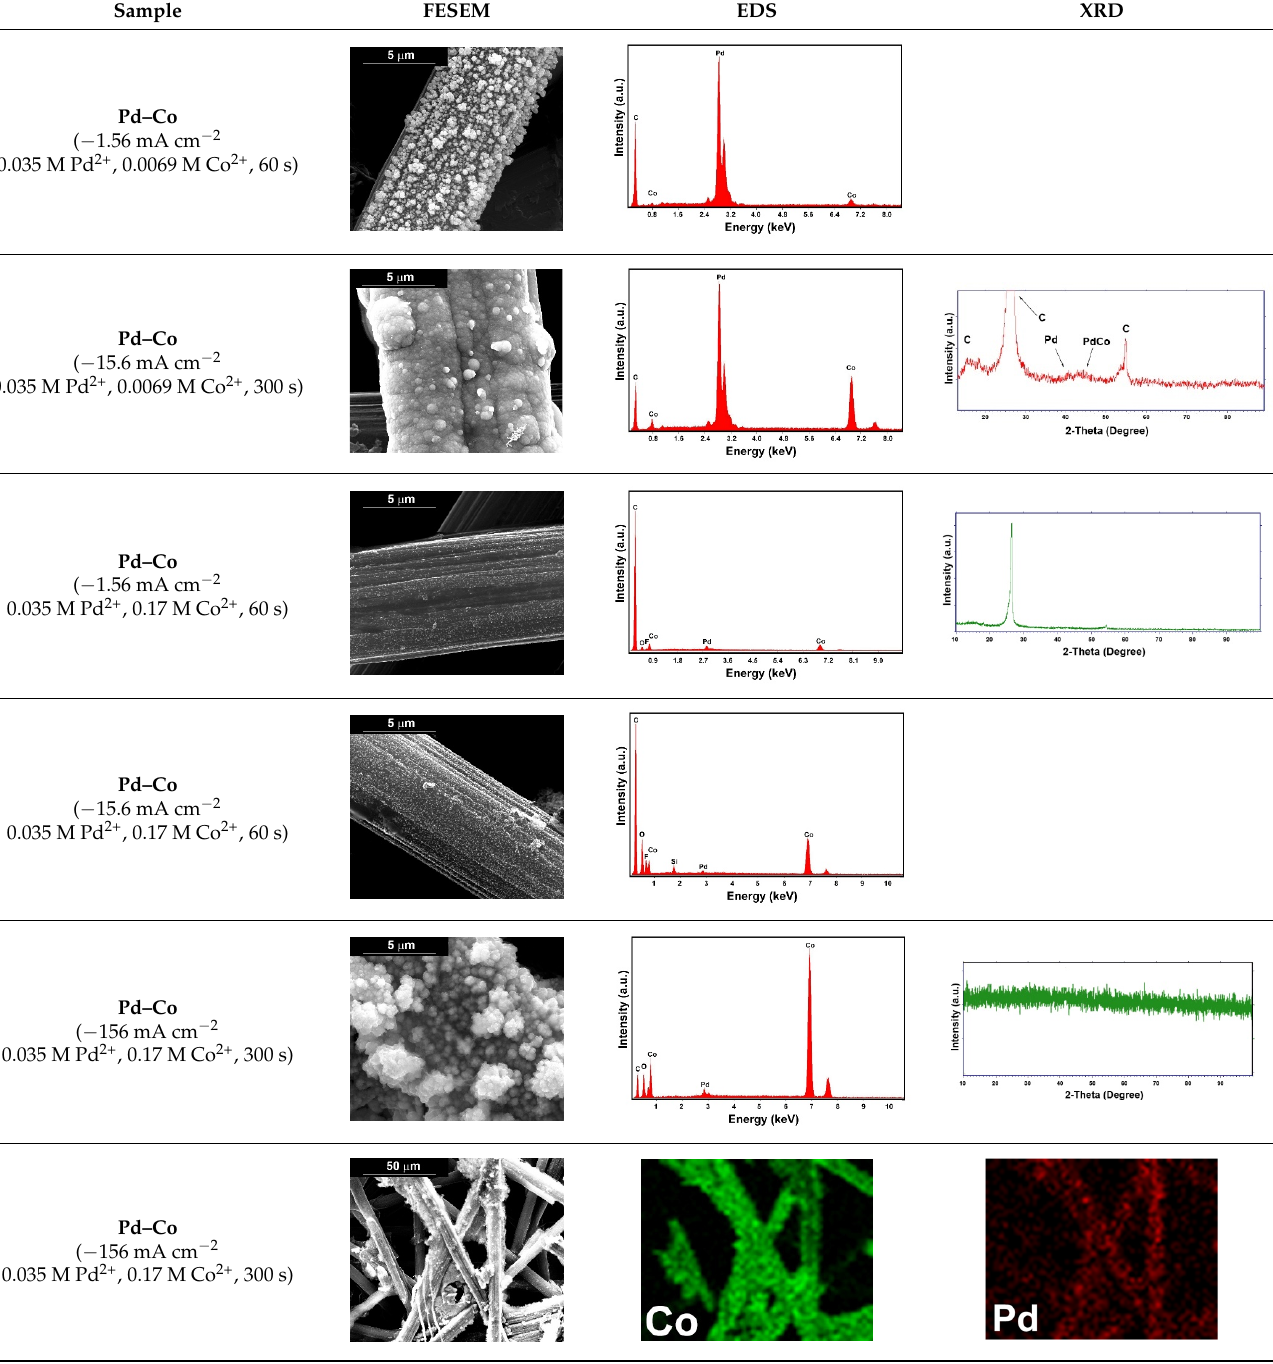
Table 2. The FESEM, EDS and XRD of CP and Pd and Co co-deposits; the